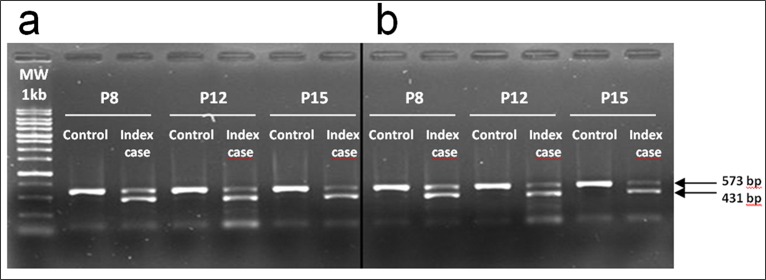
Amplification results of the splicing region.Results of the amplification of the 573 bp region of cDNA from preadipocytes from the index case and control subject in different passages without Intralipid treatment (a) or in the presence of Intralipid (b). Only samples from the index case show the presence of the 431 base pair-long additional band which once sequenced confirmed the skipping of exon 7.